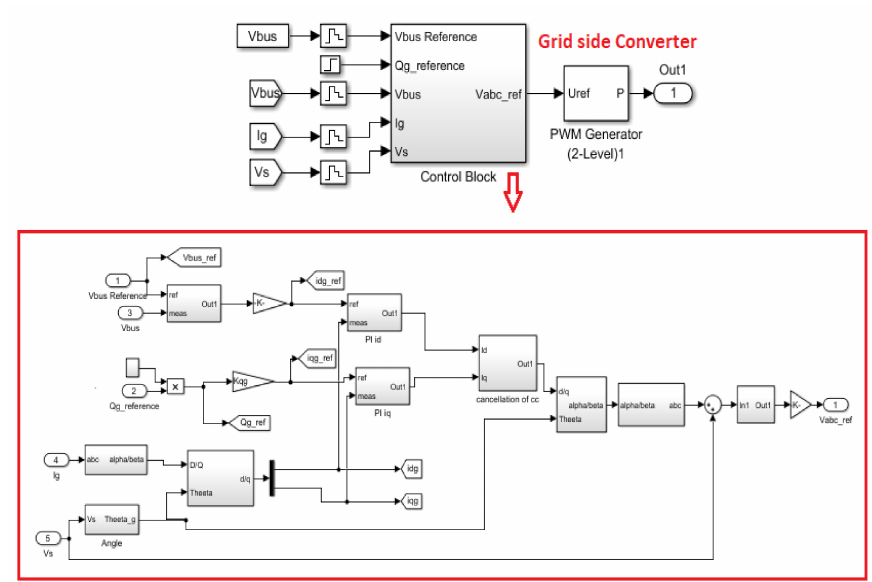
Figure 7. Grid side